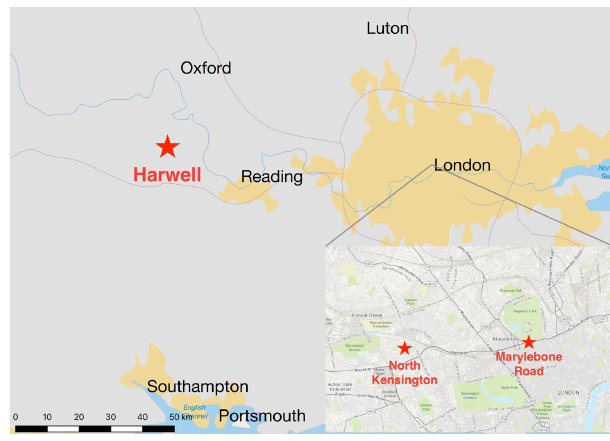
Figure 1. Map of the measuring